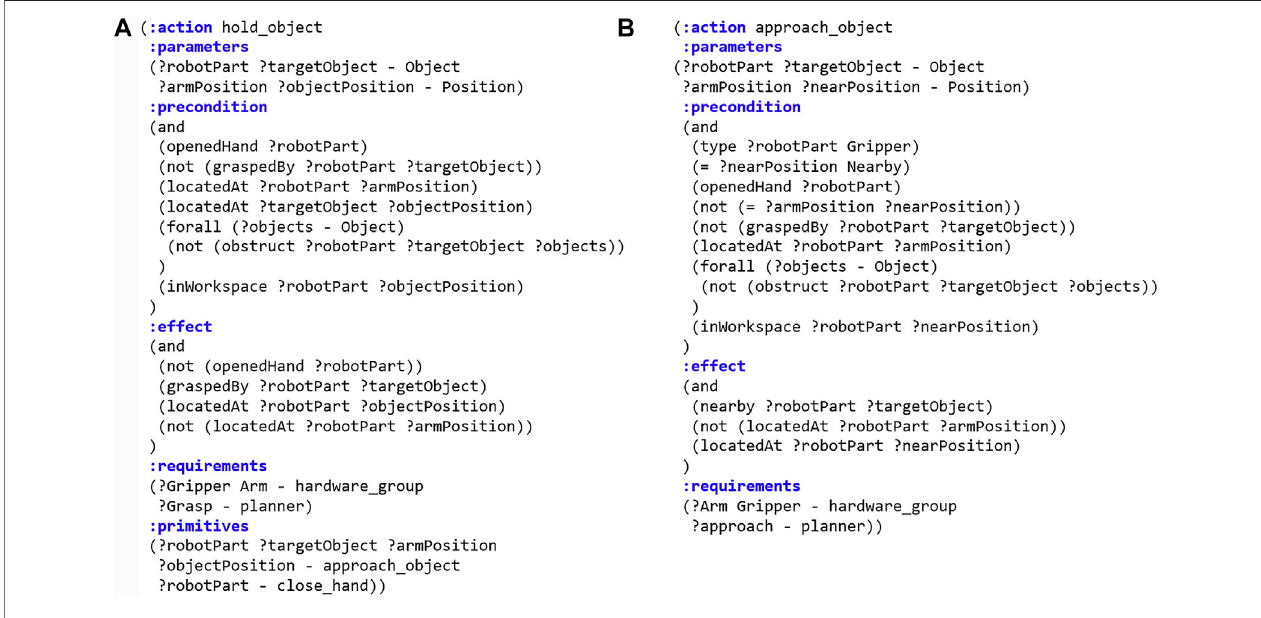
FIGURE 2 | PDDL representation of actions. (A) Compound action hold_object . (B) Primitive action approach_object .